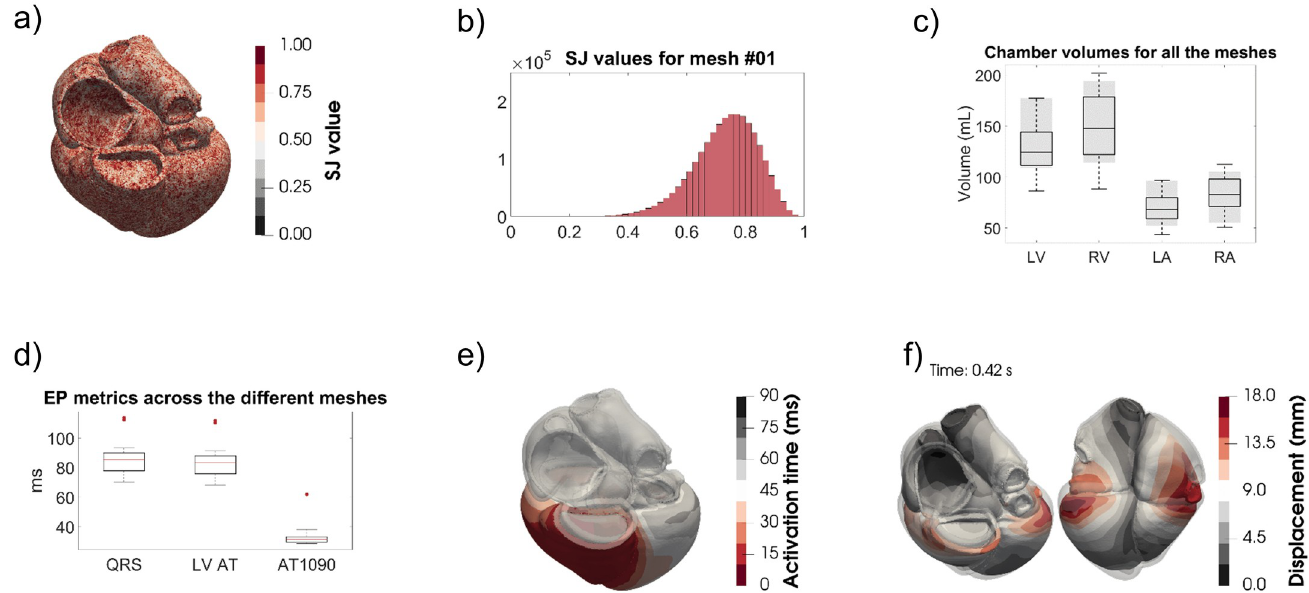
Fig 3. The different quality checks done on the meshes. a) Example of the SJ values projected in a mesh (#01). b) The histogram corresponding to the SJ values of a). c) The blood pool volumes compared with those in the UK Biobank (shaded grey). d) The activation times as described in the text. e) An example of the activation times (each isochrone corresponding to 10 ms). f) The displacement of the mechanics simulation (in translucid the end-diastolic configuration) for mesh #01.